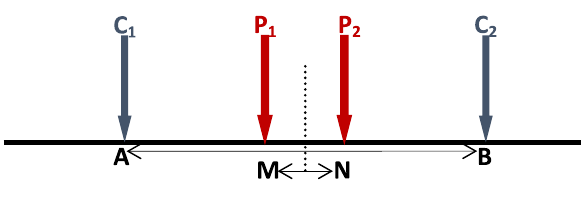
Fig. 2 A schematic illustration of Schlumberger